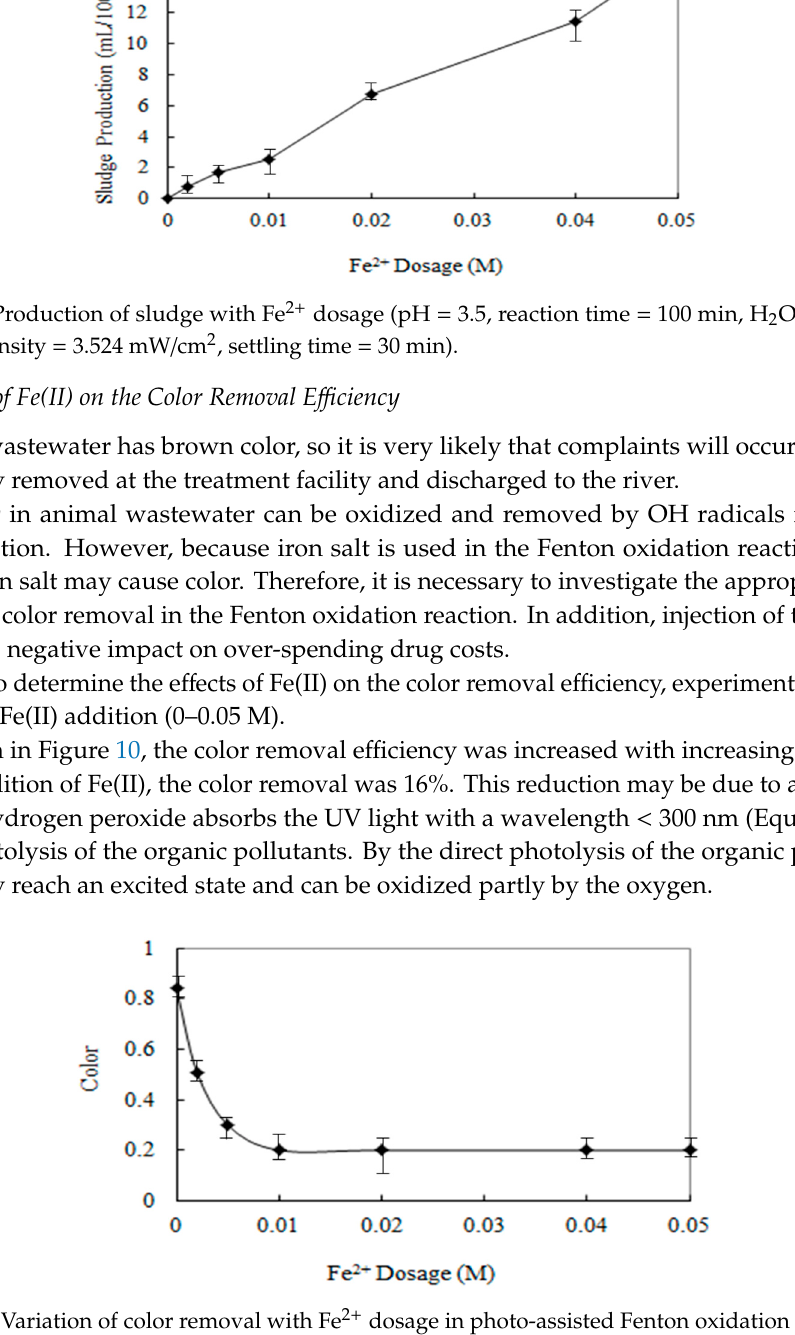
Figure 10. Variation of color removal with Fe 2 + dosage in photo-assisted Fenton oxidation (pH = 3.5, H 2 O 2 = 0.1 M, UV 254 intensity = 3.524 mW / cm 2 ).